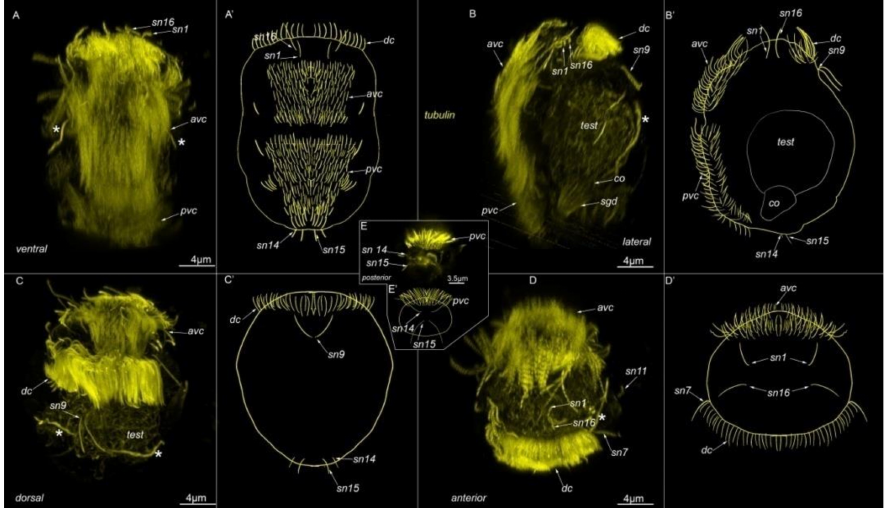
Figure 3. External ciliation in mature Dimorphilus gyrociliatus dwarf male revealed by anti-acetylated alpha-tubulin labeling. On ( A – C ) apical end is up. ( A , A (cid:48) ) Ventral view on wholemount. At the anterior part of the body, there is a prominent anterior ventral ciliary field ( avc ). The posterior ciliary field is located posteriorly the anterior ventral ciliary field. A pair of protonephridia (*) is located symmetrically on the body. At the anterior end prominent cilia of sensory neurons № 1 and № 16 are visible. ( B , B (cid:48) ). Lateral view on wholemount. At the anterior part of the body, the dorsal ciliary field ( dc ) is present. Posteriorly, two single cilia of sensory neurons № 9 are located. A prominent testis ( test ) fills the most of the inner part of the body. Posteriorly to testis copulatory organ with multiple stylet glad cells ( sgd ) are located. ( C , C (cid:48) ). Dorsal view on wholemount. ( D , D (cid:48) ). Anterior view of the wholemount. ( E , E (cid:48) ). The posterior surface of wholemount. At the posterior tip cilia of paired sensory neurons № 14 and № 15 are located. Abbreviations: avc —anterior cilia; dc —dorsal